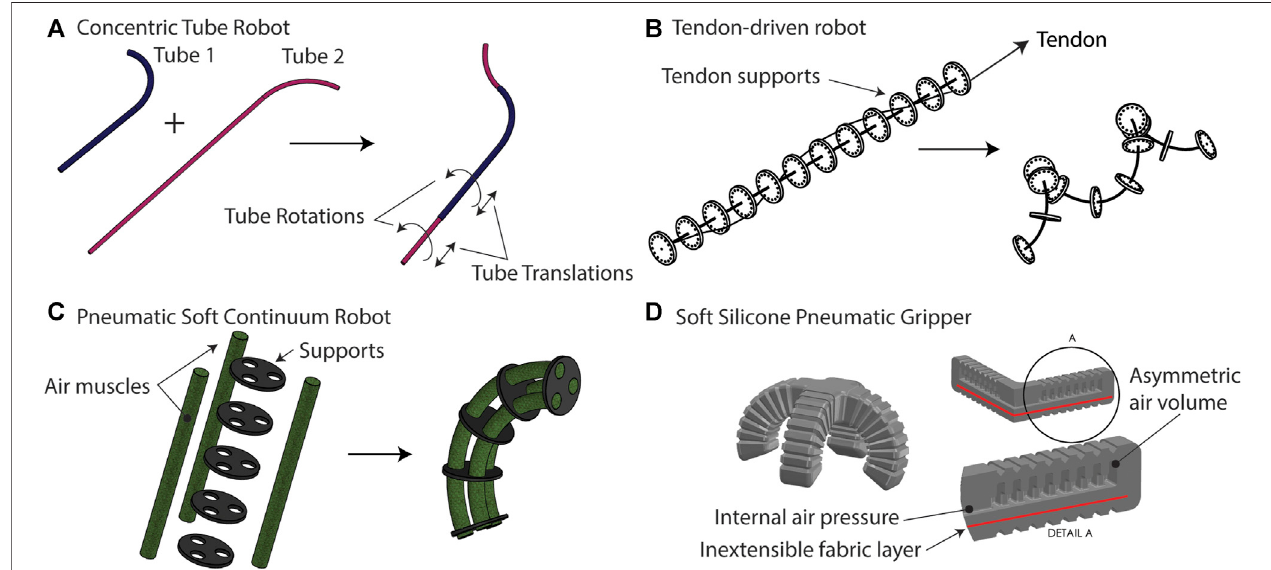
FIGURE 1 | (A) Concentric tube robots are comprised of hard (metallic) tubes which are precurved and nested inside one another. Rotating and translating the tubes results inmotion. (B) Tendon-drivenrobots useone ormore tendons orcables toprovideinternalactuation forces thatbend a fl exible, slenderrod. (C) Pneumatic softcontinuumrobotsusesoftairmuscles,whichextendorcontractwithinternalairpressure,tocreatebendinginacompositestructure.Thesupportscouldbehardor soft materials. (D) A fully soft pneumatic gripper uses asymmetry introduced by an inextensible fabric layer and an asymmetric air volume to create four slender fi ngers which bend to wrap around objects.